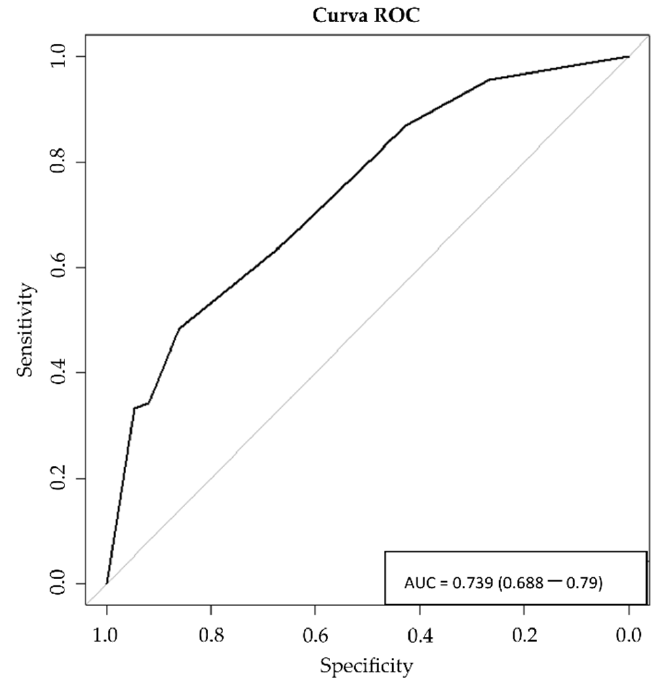
Figure 1. ROC curve 1 . Predictive value of the model. AUC = 0.739 (0.688–0.79) 2 . ( 1 ROC = Receiver operating characteristic curve; 2 AUC = Area Under Curve).